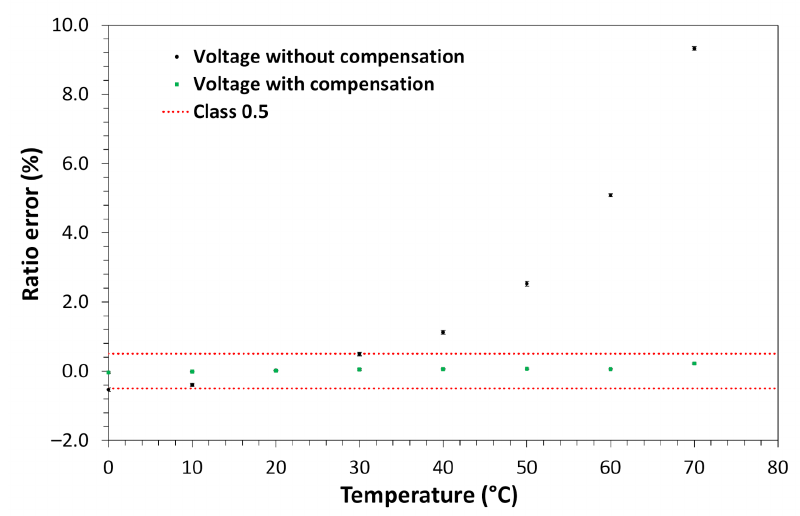
Figure 9. Voltage sensor measurements with and without temperature compensation.